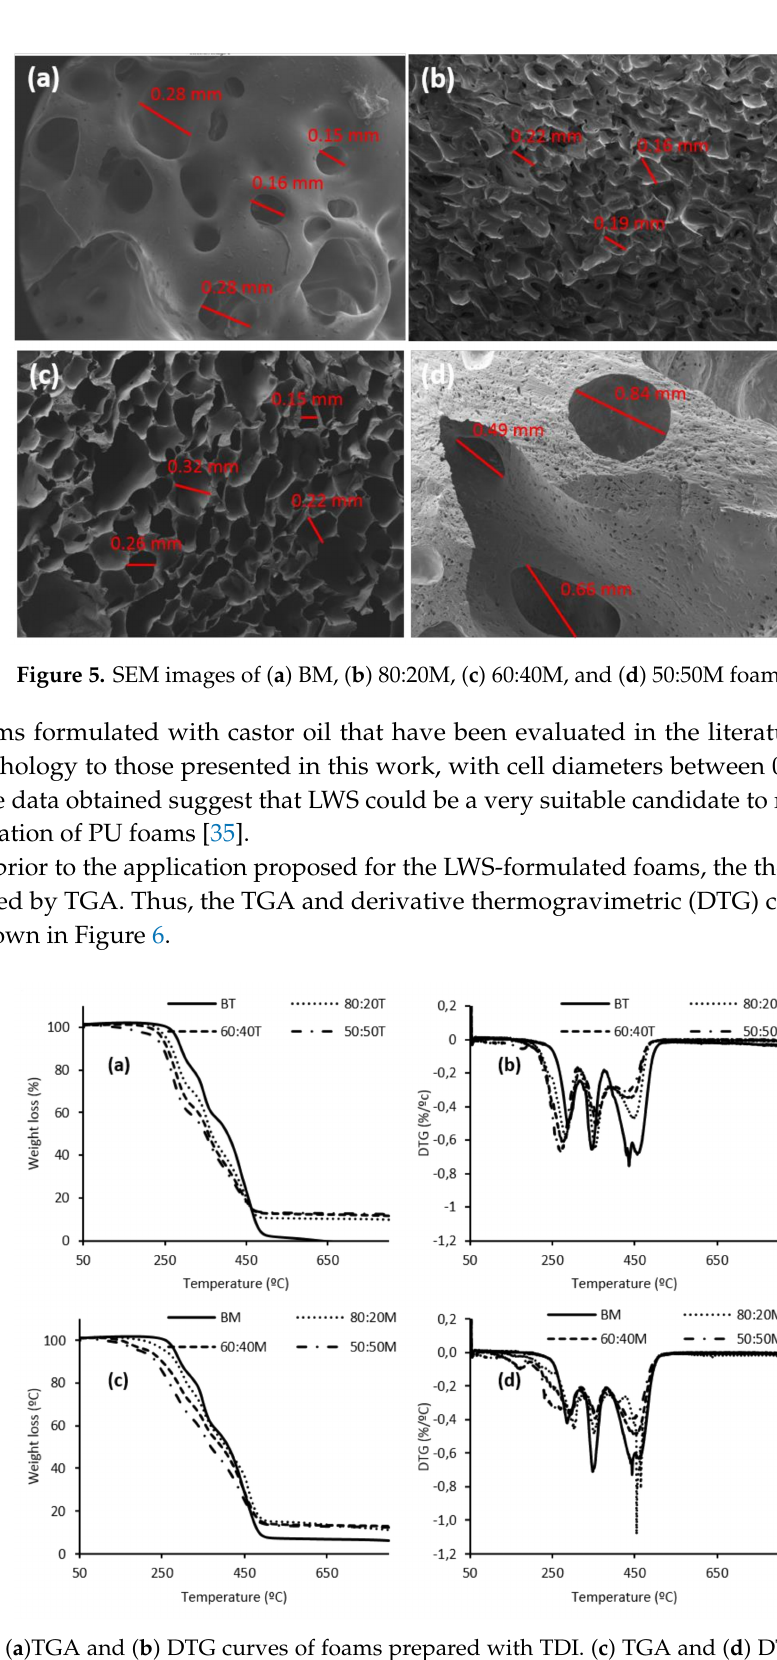
Figure 6. ( a )TGA and ( b ) DTG curves of foams prepared with TDI. ( c ) TGA and ( d ) DTG curves of foams formulated with